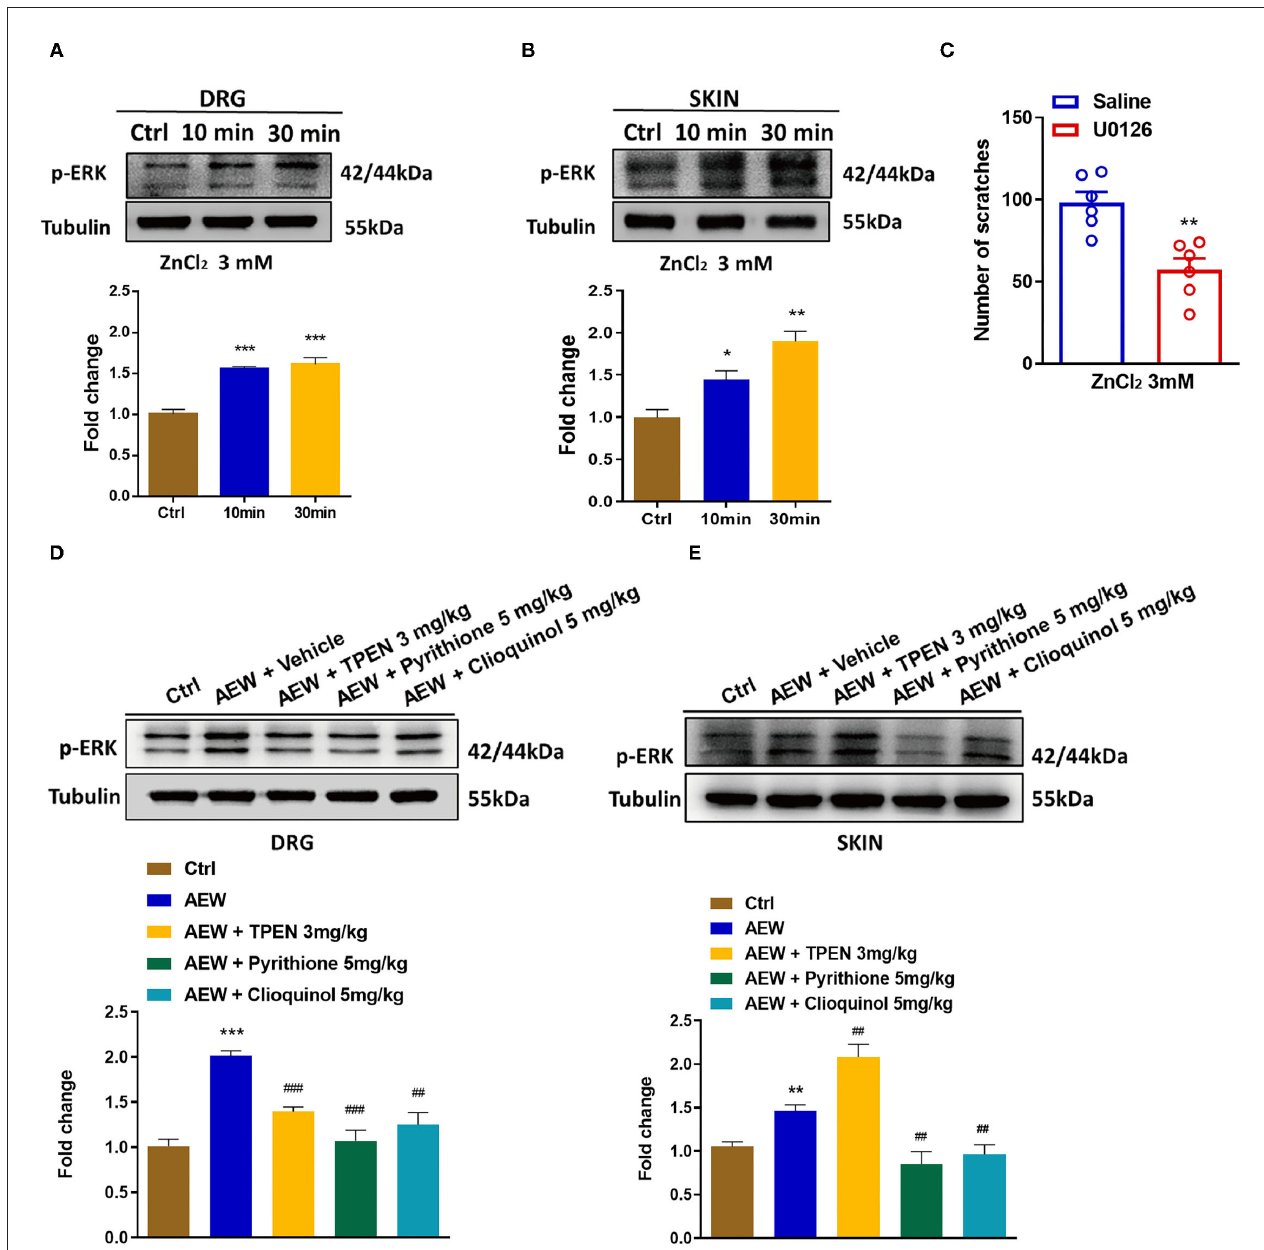
FIGURE 8 | Activation of extracellular signal-regulated kinase (ERK) signaling was involved in Zn 2 + -mediated acute and chronic itch in mice. (A,B) Western blots (upper panel) and quantification (lower panel) shows that p-ERK expression is significantly increased at 10 and 30min in DRG (A) and skin (B) after i.d. injection of ZnCl 2 (3mM) (* P < 0.05, ** P < 0.01, *** P < 0.001 vs. Ctrl, unpaired Student’s t -test; n = 4). (C) Intrathecal injection of U0126 (1 nmol) decreased the ZnCl 2 -induced scratching behavior in mice by 3mM (** P < 0.01 vs. Saline, unpaired Student’s t -test; n = 6). (D,E) Western blots (upper panel) and quantification (lower panel)